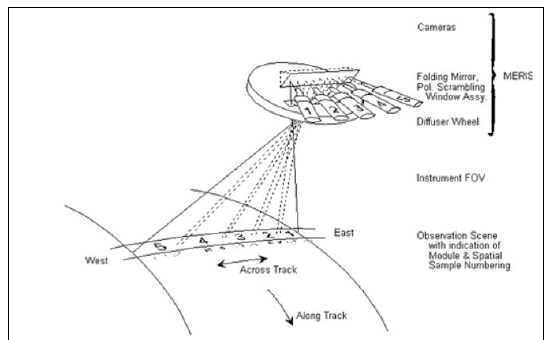
Figure 11. MERIS imaging principle from ESA MERIS Product Handbook (MERIS, 2011).